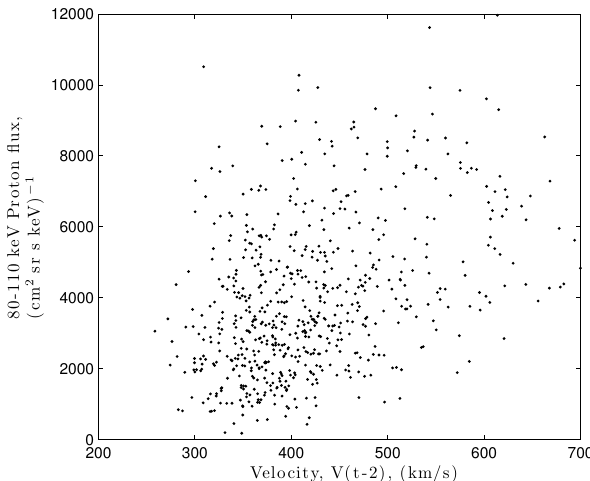
Fig. 1. A scatter plot for the daily averaged 80–110keV proton flux and solar wind velocity recorded two days